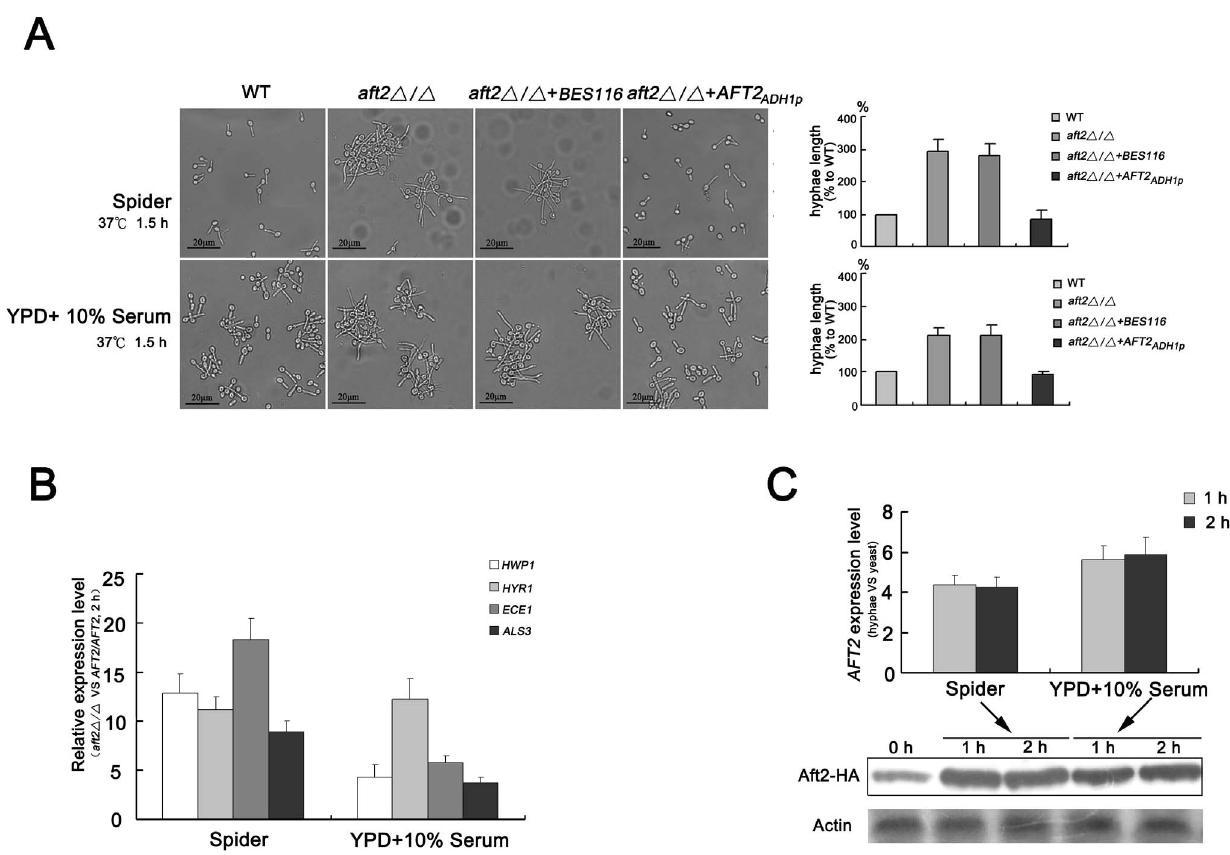
Figure 7. The enhanced hyphal development of AFT2 deletion is closely associated with increased expression of hypha-specific genes in C.albicans . (A) Cells were incubated in liquid YPD + 10% serum and Spider medium at 37 u C, respectively. At the time indicated, the samples were examined and photographed by light microscopy. Hyphal lengths in the wild-type, aft2 D / D mutant, aft2 D / D + Vector (NKF90) and AFT2 - overexpression complemented (NKF91) strains were measured, and shown in the graph. (B) After 2 h incubation in liquid inducing medium, cells were harvested and used for RNA isolation. Quantitative expression levels were determined by real-time PCR assays. (C) The strains producing Aft2- HA fusion proteins were incubated for 0 h, 1 h and 2 h in indicated liquid inducing medium, respectively. Then, cells were harvested and used for RNA isolation and protein extraction. Immunoblot analysis was performed using an anti-HA antibody to detect tagged Aft2 proteins. Actin was detected with anti-actin antibody as a loading